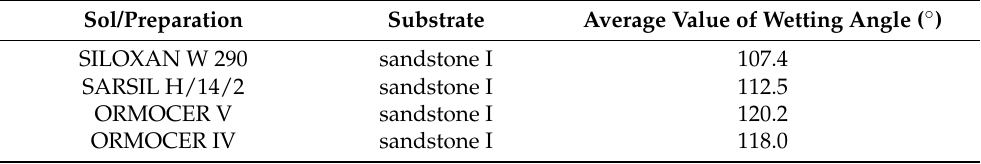
Table 3. Wetting angle values of sandstone I.